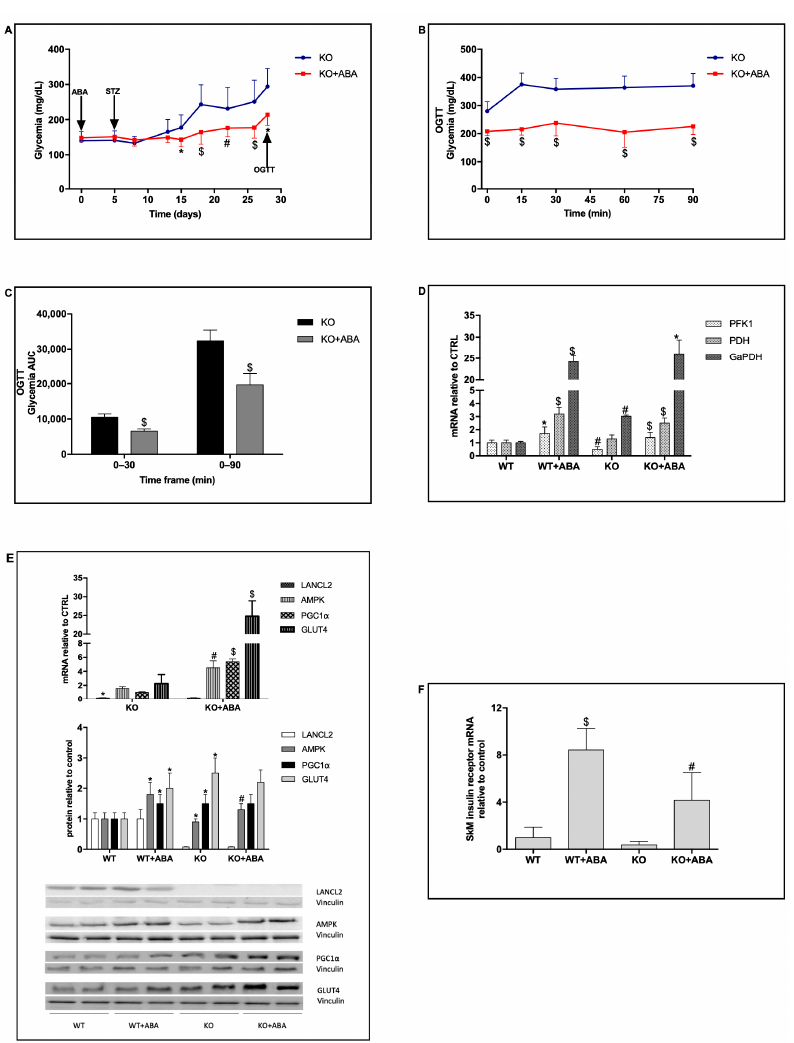
Figure 4. Chronic ABA treatment improves the glycemia profile in LANCL2 KO mice and increases transcription of glycolytic enzymes in the skeletal muscle. Eight-week old LANCL2 − / − (KO)